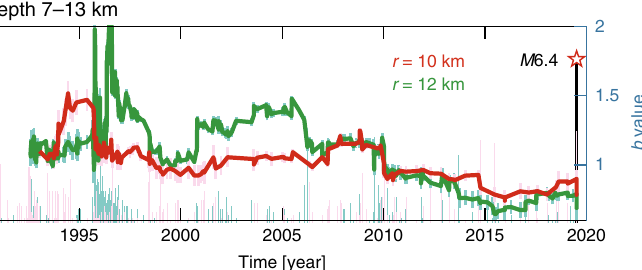
Fig. 1 Ridgecrest earthquake sequence and b -values. a Map of earthquakes in the Ridgecrest region. The cross-section in Fig. 2 extends from P 1 to P 2 and from P 3 to P 4 with a width of 8 km. Inset shows the study region (black rectangle). Thin lines indicate major mapped faults. Los Angeles, Santa Barbara, Ridgecrest, and Coso geothermal fi eld are indicated as LA, SB, RC, and Coso GF, respectively. b Map of b -values obtained from seismicity ( M ≥ 1) at a depth of 7-13 km before the M 6.4 quake. Inset: the b -value map at a depth of 0 – 7 km. c Plot of b as a function of time before the M 6.4 quake for seismicity (depth of 7 – 13 km) falling in the circle with a radius of r = 10 km (red) and 12 km (green), centered at the M 6.4 epicenter. Moving windows cover 100 events. Also included is the magnitude-time